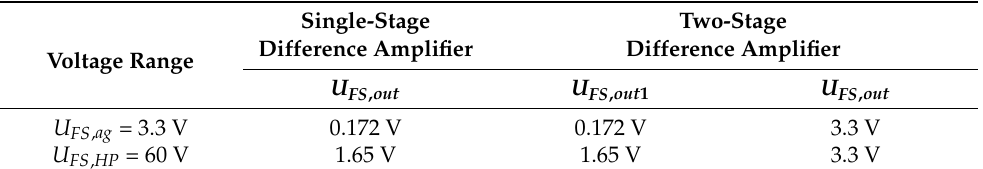
Table 2. Comparison between calculated U FS , out for corresponding single- and two-stage ampli- fiers’ setpoints.